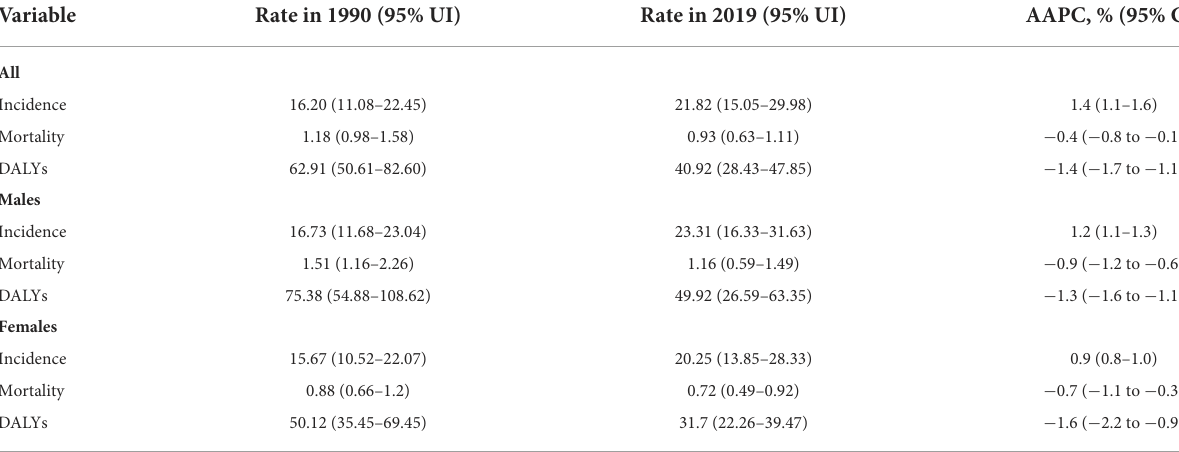
TABLE 1 Trends in the burden of carbon monoxide poisoning between males and females in China from 1990 to 2019.